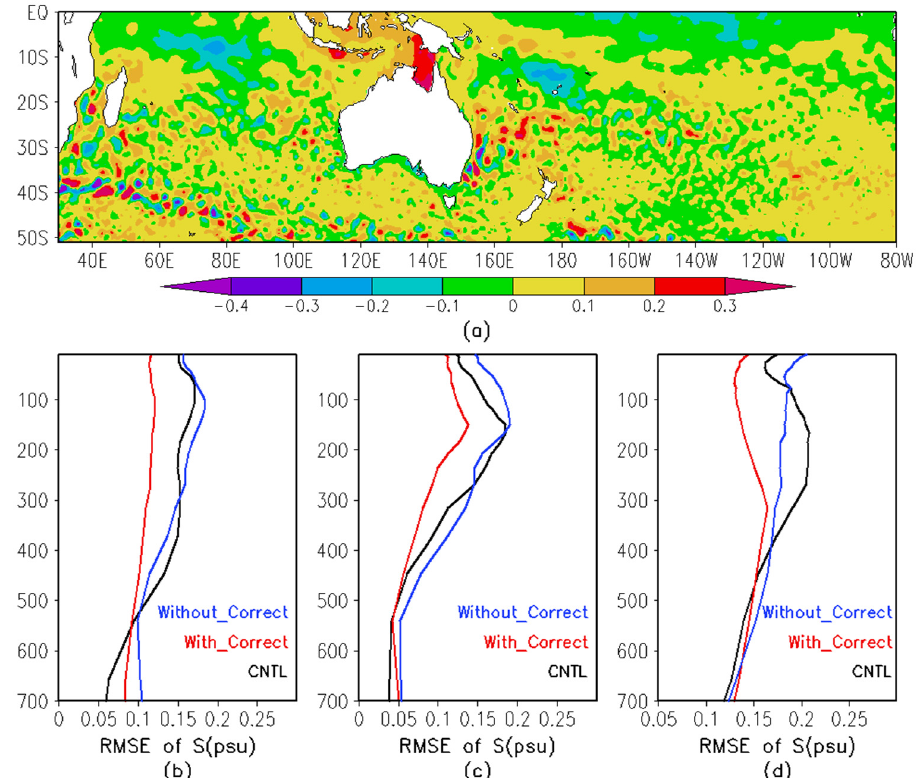
Figure 6. Observed SLA in Jan 1999 ( a ) and vertical distribution of the RMSEs of salinity ( b – d ) for different regions and different experiments over the period 1993–2005. ( b ) Southern Pacific Ocean west of 150° W, ( c ) Southern Pacific Ocean east of 150° W, ( d ) Southern Indian Ocean (30° E–40° E, 40° S–35° S).